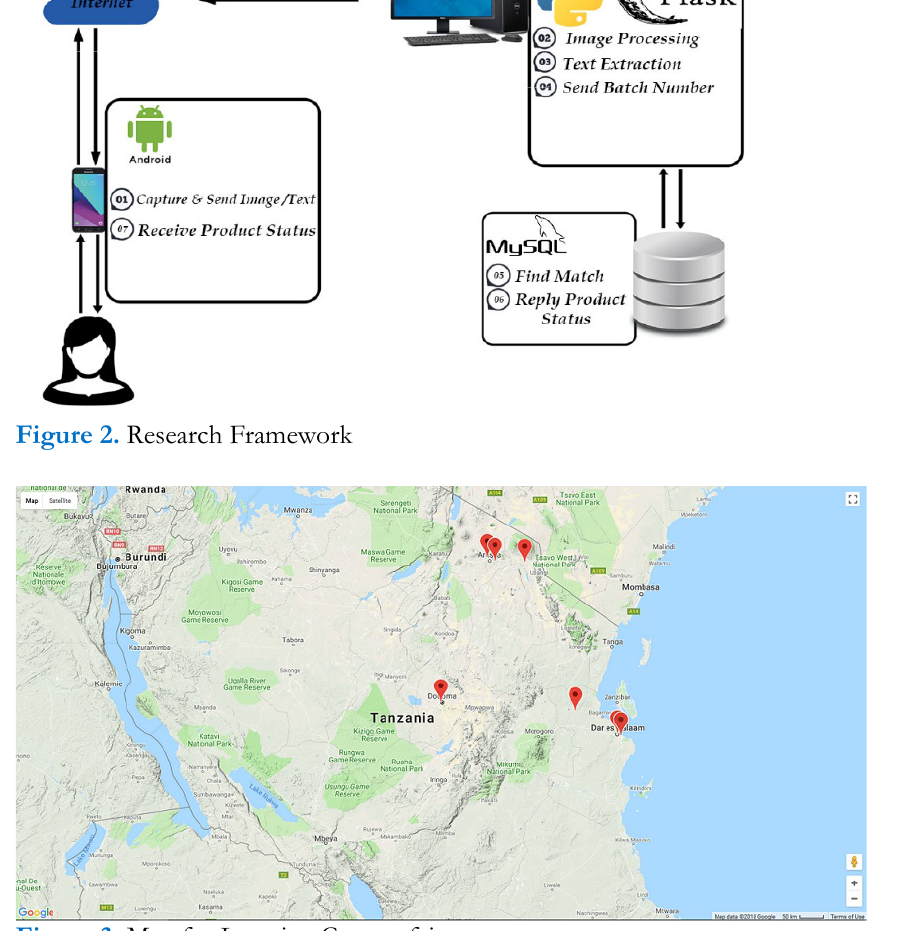
Figure 3. Map for Locating